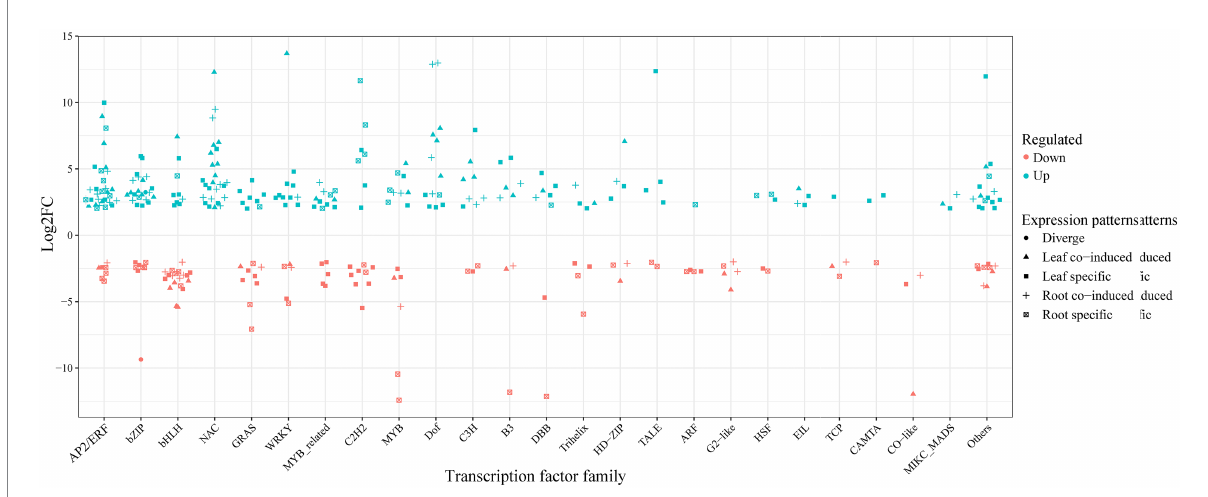
FIGURE 6 The expression pattern distribution of the most enriched transcription factors in response to cold-drought stress between leaves and